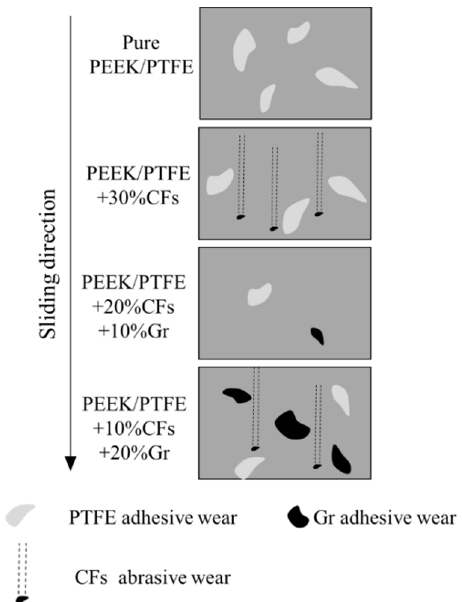
Figure 6. Schematic illustration of the wear mechanisms of PEEK/PTFE composites with different contents of CFs and Gr.